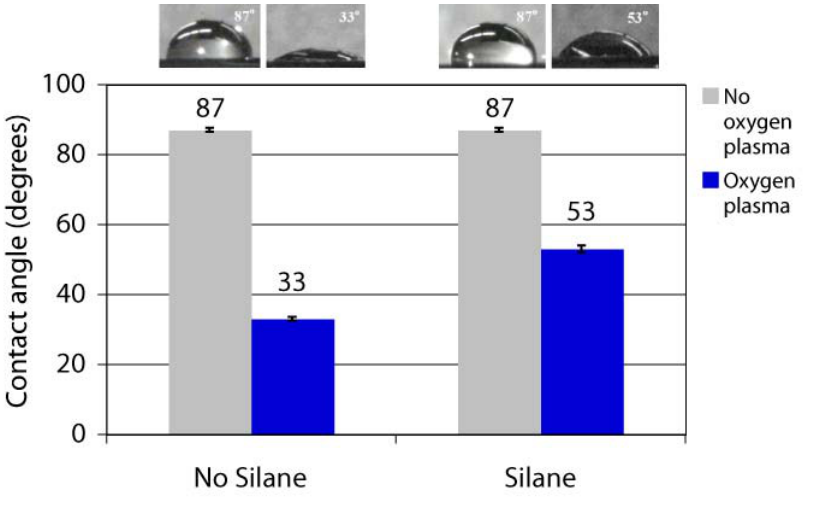
Figure 3. Water contact angles of parylene following different treatments: with oxygen plasma etch and/or silanisation with a hydrophilic